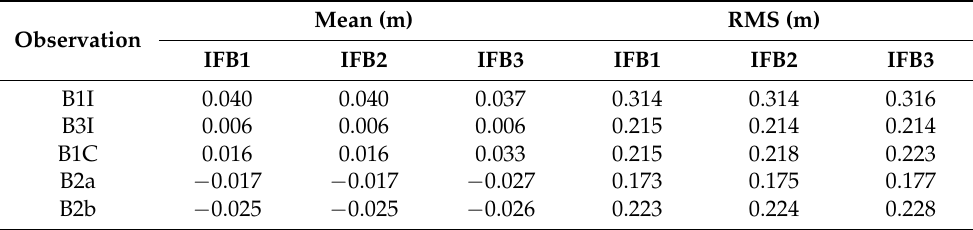
Figure 4. The phase residuals for BDS-3 UC-PPP of IFBs for stochastic modeling of random constant for station KRGG on DOY 001, 2022. The residuals of each satellite are represented with different colors. The right part of each subfigure shows the histogram of the residuals and the fitted normal density function (red line). Table 4. The means and RMS of the phase residuals among different IFCB handling schemes. Table 3. The means and RMS of the pseudorange residuals among different IFCB handling schemes.